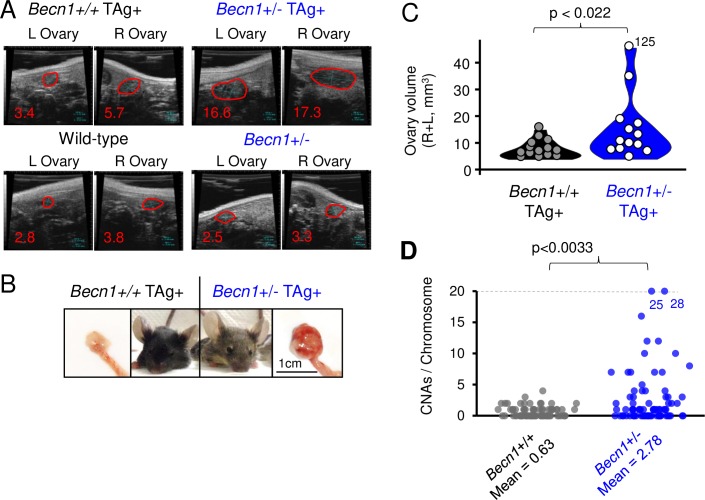
Becn1+/- mice present early ovarian tumors.A, Ultrasound images of tumor size at 12 weeks of age in the MISIIR Large-T-Antigen (TAg+) ovarian cancer mouse model. Example tumors for each genotype are shown for both left (L) and right (R) ovaries. Non-TAg+ controls are shown for comparison. B, Example 12-week tumors are shown and juxtaposed with an image of the mouse model, with characteristic large ears (TAg model) and brown fur coat (Becn1+/- model). C, Quantitation of all mice studied for ovarian size at 12 weeks of age. N = 13 for Becn1+/- TAg+, N = 14 for Becn1+/+ TAg+ mice. Wilcoxon rank-sum test was used to determine the P-value. D, Terminal ovarian tumors were isolated for genomic DNA and assayed by whole-genome sequencing. Becn1+/- tumors displayed higher rates of CNAs per chromosome. Two outlier chromosomes are labeled for CNA counts beyond the edge of the y-axis. N = 4 mice per group for whole-genome copy-number analysis; each data point represents one chromosome. Wilcoxon rank-sum test was used to determine the P-value.